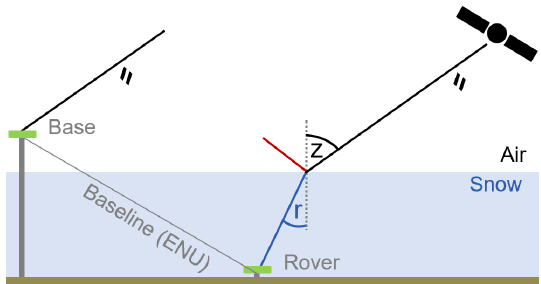
Figure 1. Simplified schema illustrating a fixed GNSS refractometry setup. The base antenna, mounted on a pole above the snowpack serves as reference. The rover antenna is installed on the solid ground and covered by snow. The GNSS signals are reflected (red) and refracted (blue) at the air/snow boundary and depend on the incidence (z) and thus refractive (r) angles. The SWE is derived from the biased GNSS baseline Up component due to the influence of the snow above the rover